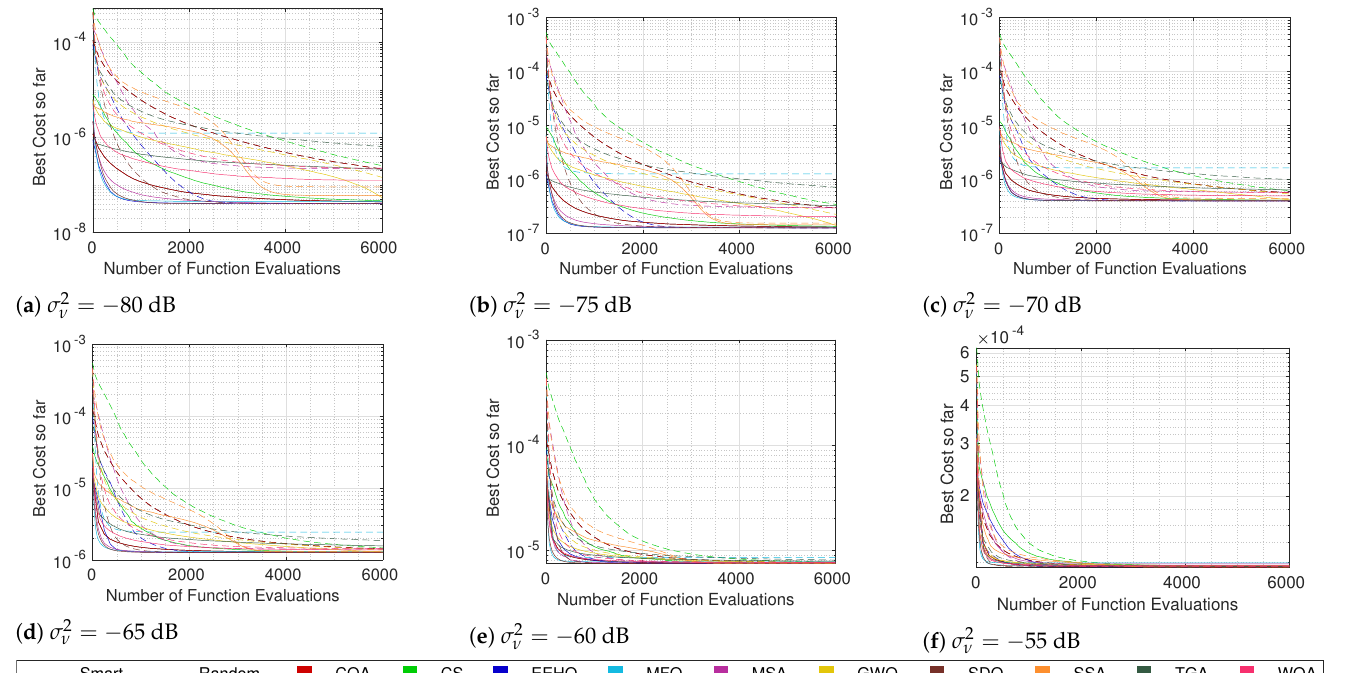
Figure 7. Cost convergence when using smart and random initialization for each algorithm when N = 6.